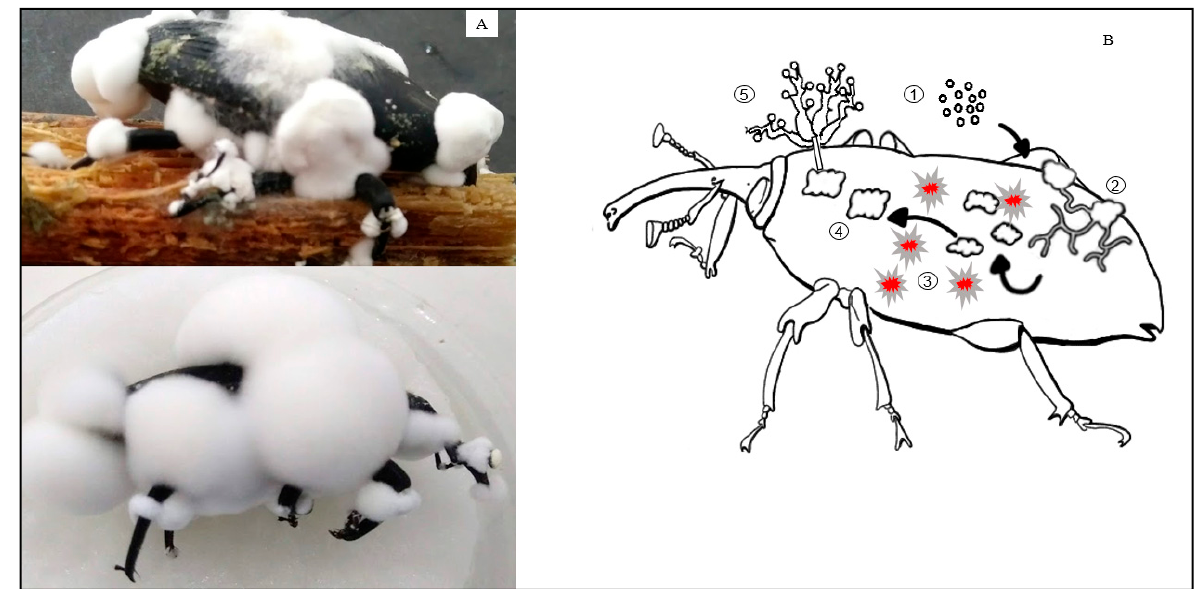
Figure 3. Schematic diagram of the infection process by B. bassiana after visiting a baiting and contaminating station. ( A ) Infection fungi process in the laboratory showing pathogenicity and mortality; ( B ) illustrative infection cycle depicted by B. bassiana in R. palmarum : (1) spore adhesion; (2) cuticle hydrolysis and breaking; (3) fungal cells change their cell structures in contact with hemolymph and secrete secondary metabolites; (4) switch to a yeast-like structure to colonize and kill the insect; and (5) sporulation.